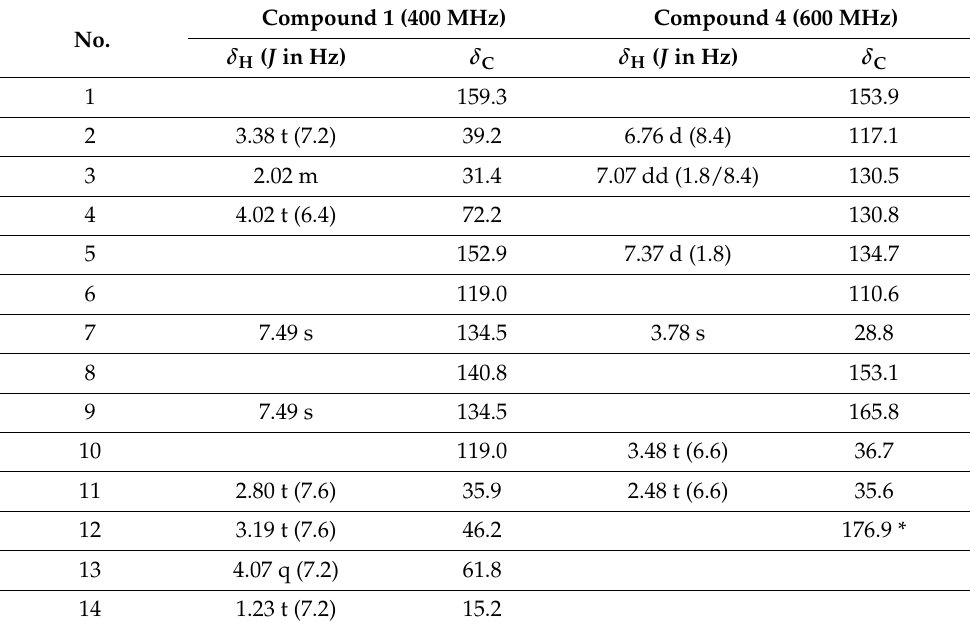
Table 1. 1 H NMR Data ( δ in ppm, J in Hz) of compounds 1 (400 MHz) and 4 (600 MHz). Compound 1 (400 No.